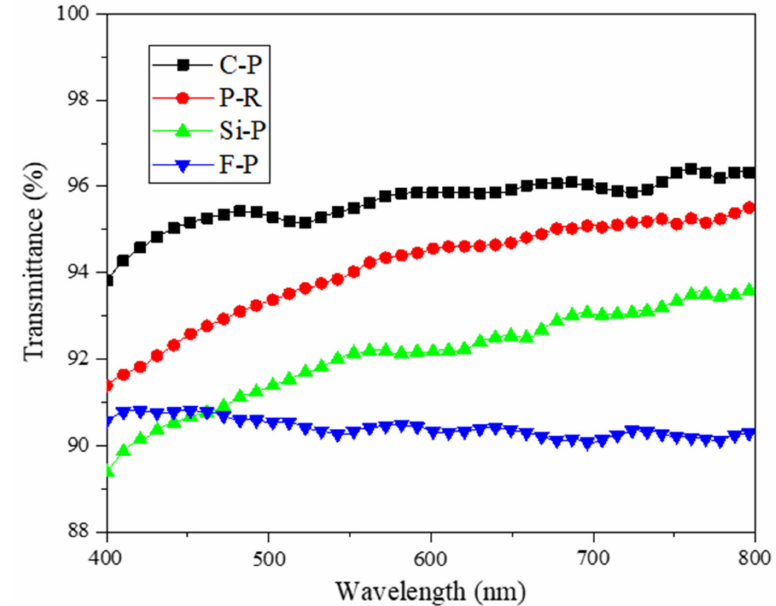
Figure 6. Transmission spectrum for each